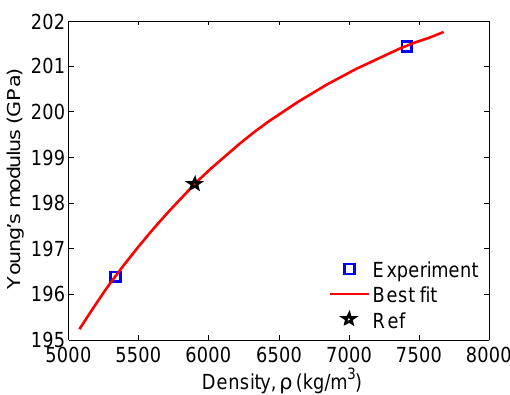
Figure 8. The variation of the Young’s modulus of the binary alloy FeAl as a function of its density. The data were generated by the setup employing the thin PZT disc transducers. The data point shown by the pentagram is from reference